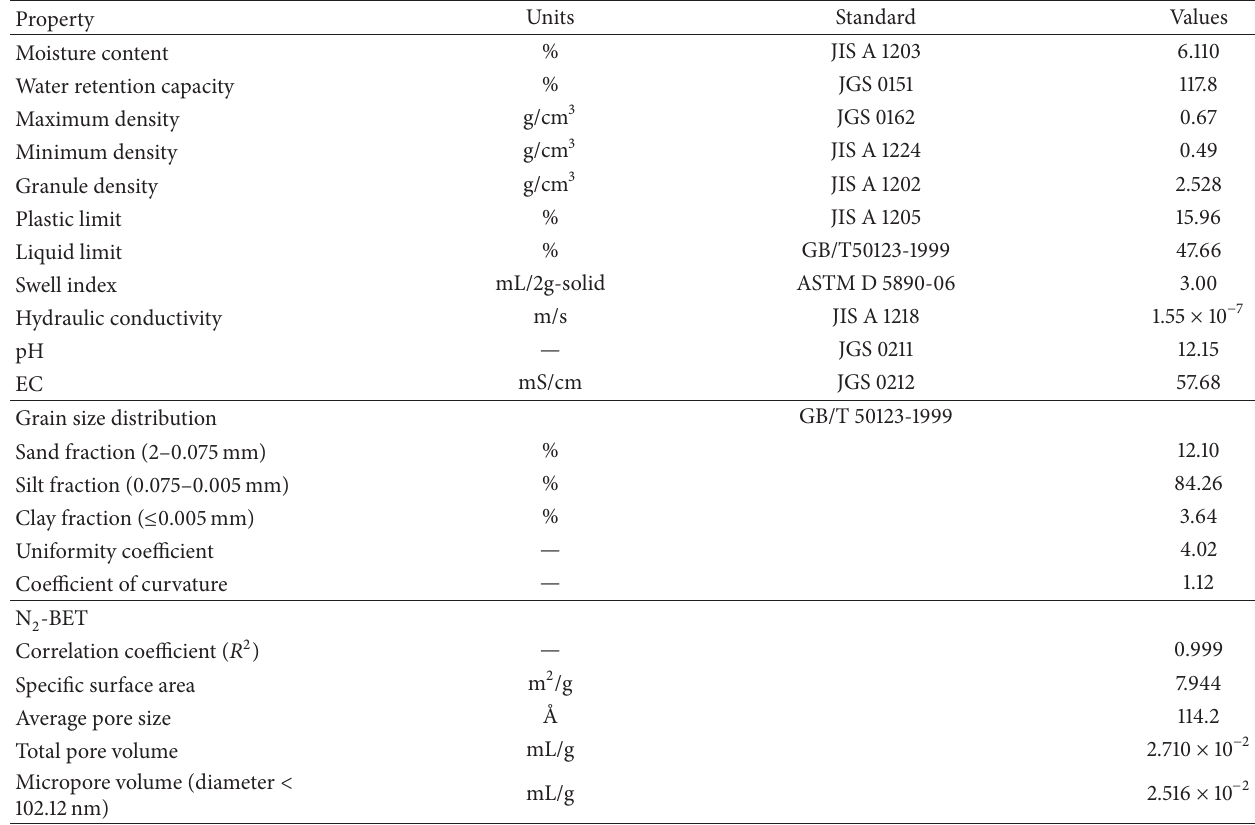
Table 2: Properties of fly